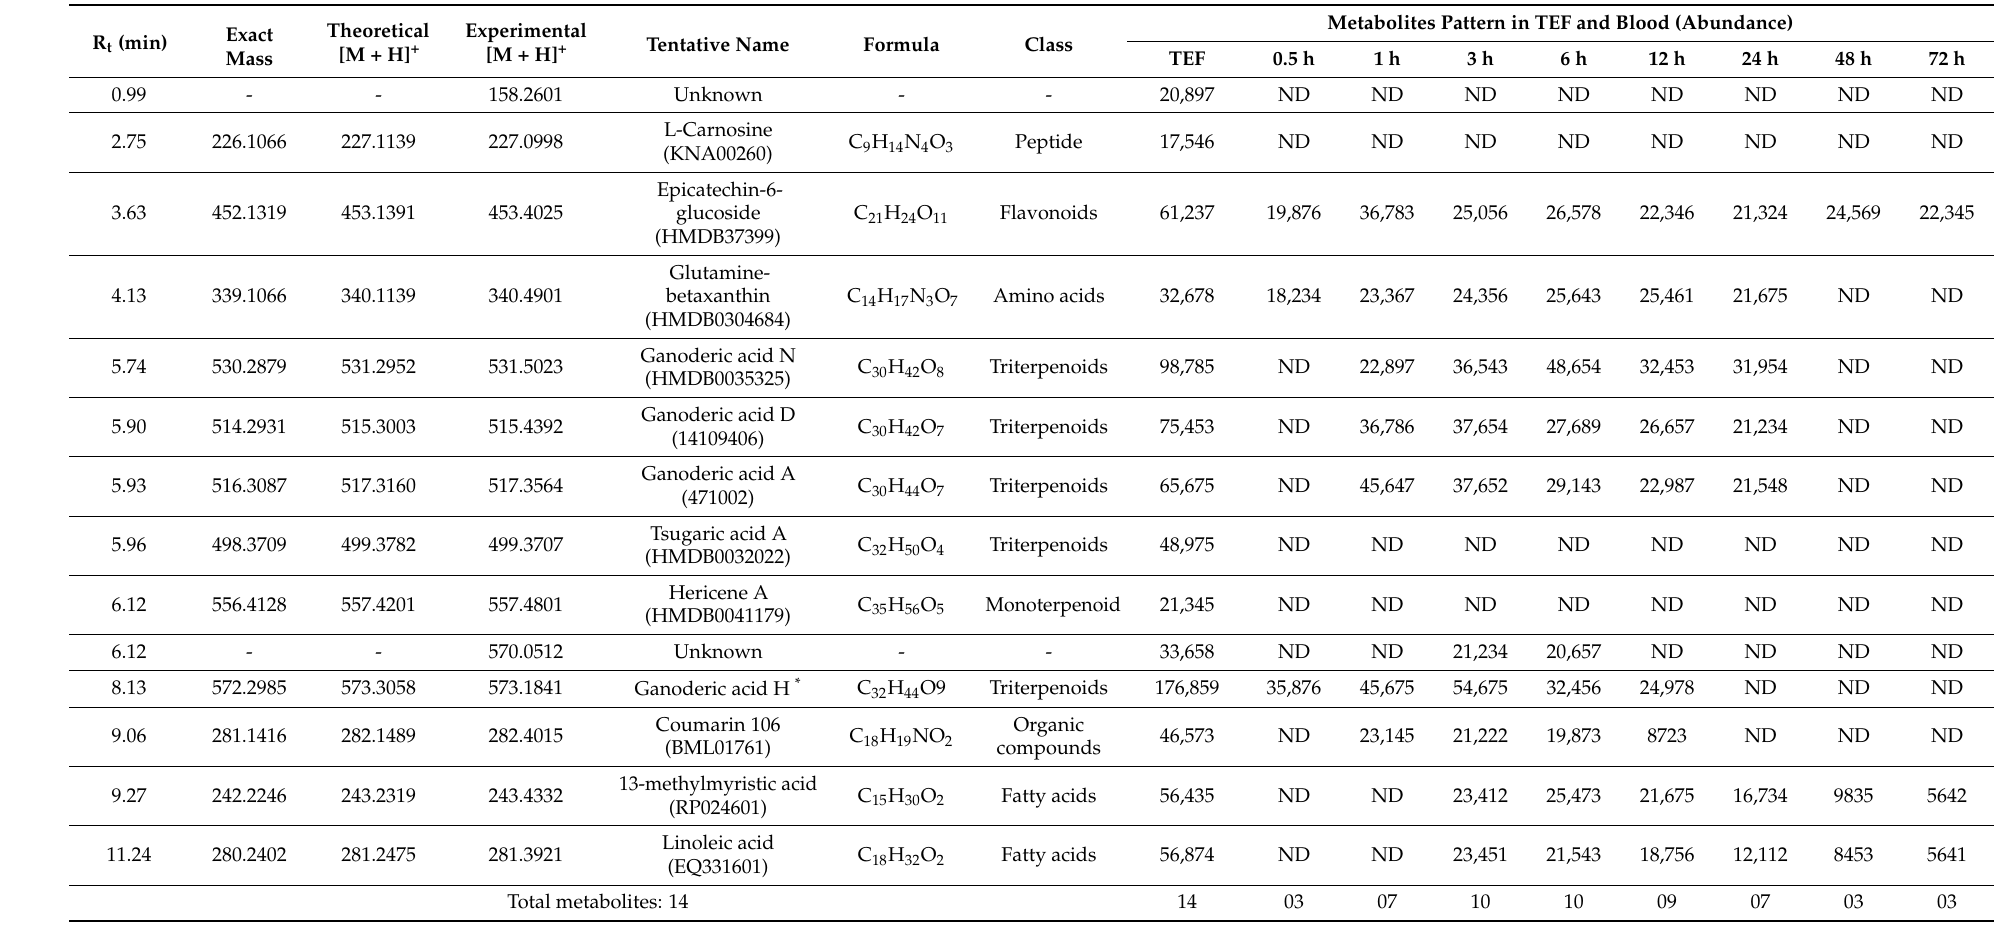
Table 1. UPLC–MS based metabolic profiling of TEF and blood sample after its oral